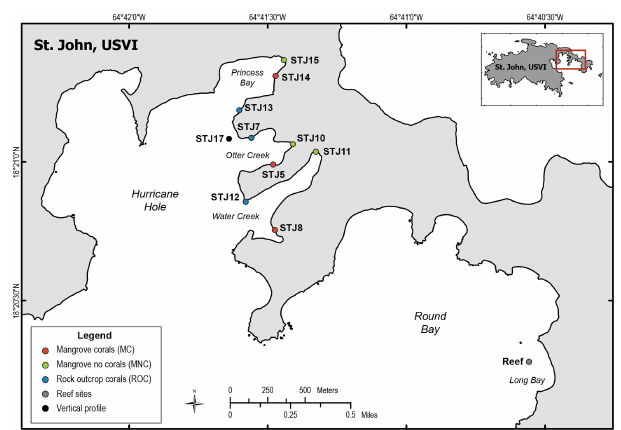
Figure 1. Study sites (STJ#) in Hurricane Hole. MC are mangroves with corals growing on and near mangrove prop roots and shaded by the mangrove canopy, MNC are mangroves with no corals growing in association with them, ROC are rock outcrops with live corals and no shading from